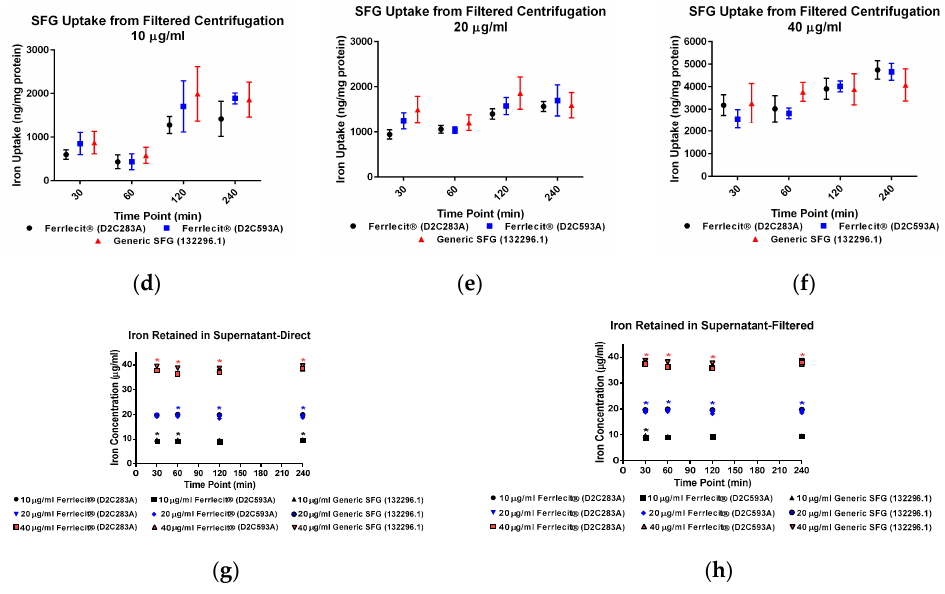
Figure 2. Comparison of iron uptake in HL-60 cells. Data are presented as mean ± SD ( n = 3, three independent experiments with four replicates for each experimental condition). A p -value < 0.05 was considered statistically significant, marked with *. ( a ) Iron uptake in HL-60 cells treated with 10 µg/mL drugs was measured from direct centrifugation harvest; ( b ) iron uptake in HL-60 cells treated with 20 µg/mL drugs was measured from direct centrifugation harvest; ( c ) iron uptake in HL-60 cells treated with 40 µg/mL drugs was measured from direct centrifugation harvest; ( d ) iron uptake in HL-60 cells treated with 10 µg/mL drugs was measured from filtered centrifugation harvest; ( e ) iron uptake in HL-60 cells treated with 20 µg/mL drugs was measured from filtered centrifugation harvest; ( f ) iron uptake in HL-60 cells treated with 40 µg/mL drugs was measured from filtered centrifugation harvest; ( g ) iron retained in cell culture supernatant was measured from direct centrifugation harvest; ( h ) iron retained in cell culture supernatant was measured from filtered centrifugation harvest.